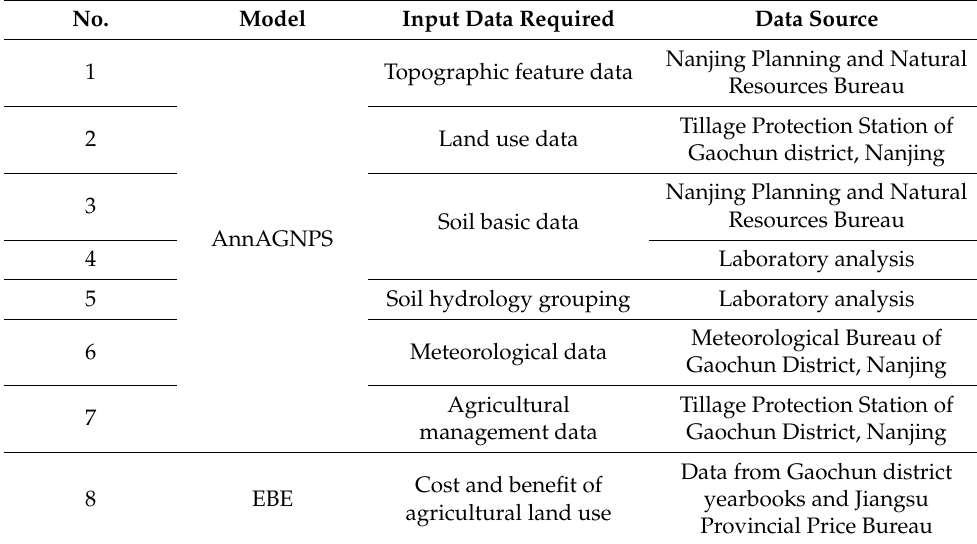
Table 1. Classification and sources of the data inputs required for the MDMS coupling